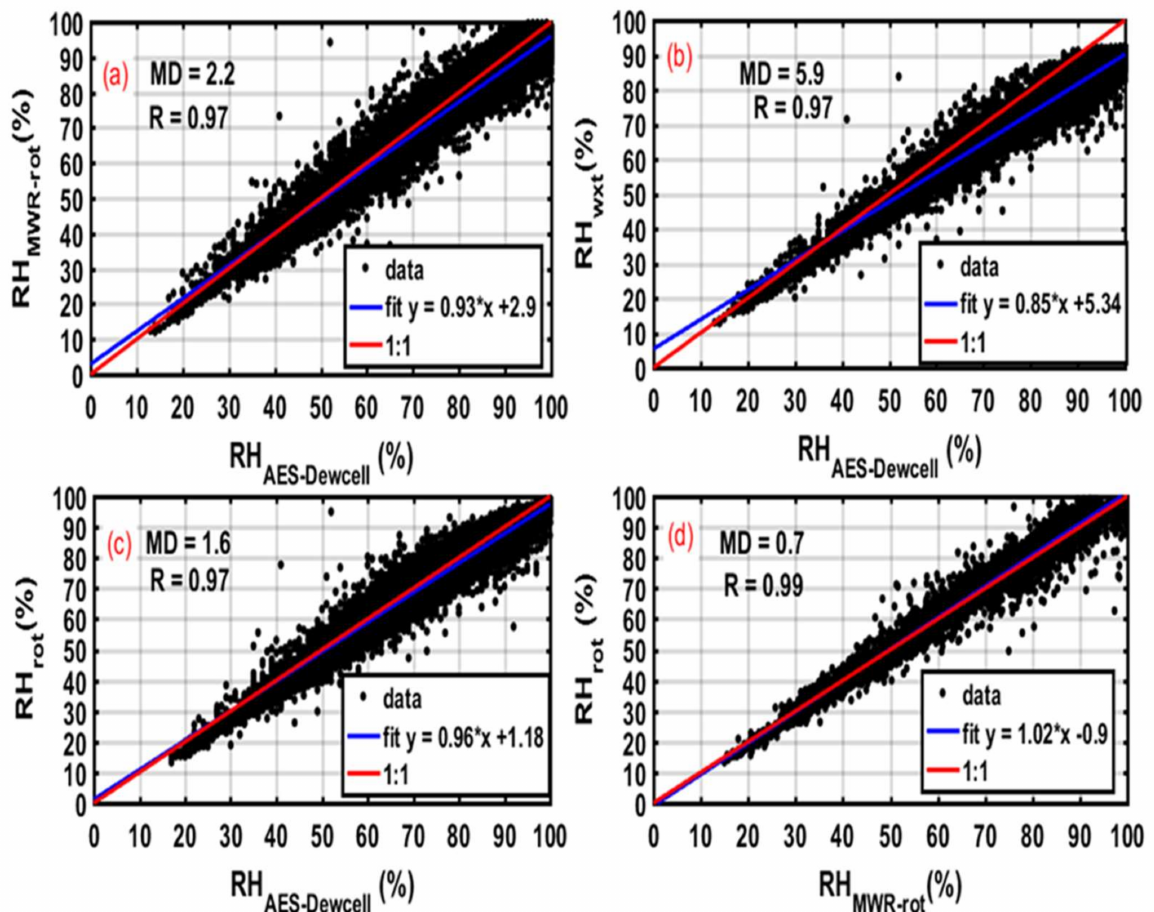
Figure 10. The relative humidity measured using the Rotronic sensor using in the MWR (RH MWR ) ( a ), the WXT520 (RH wxt ) ( b ), and a second Rotronic sensor (RH rot ) ( c ), plotted against the AES-Dewcell sensor ( d ), and the comparison of the two Rotronic sensors (RH rot and RH MWR-rot ) ( d